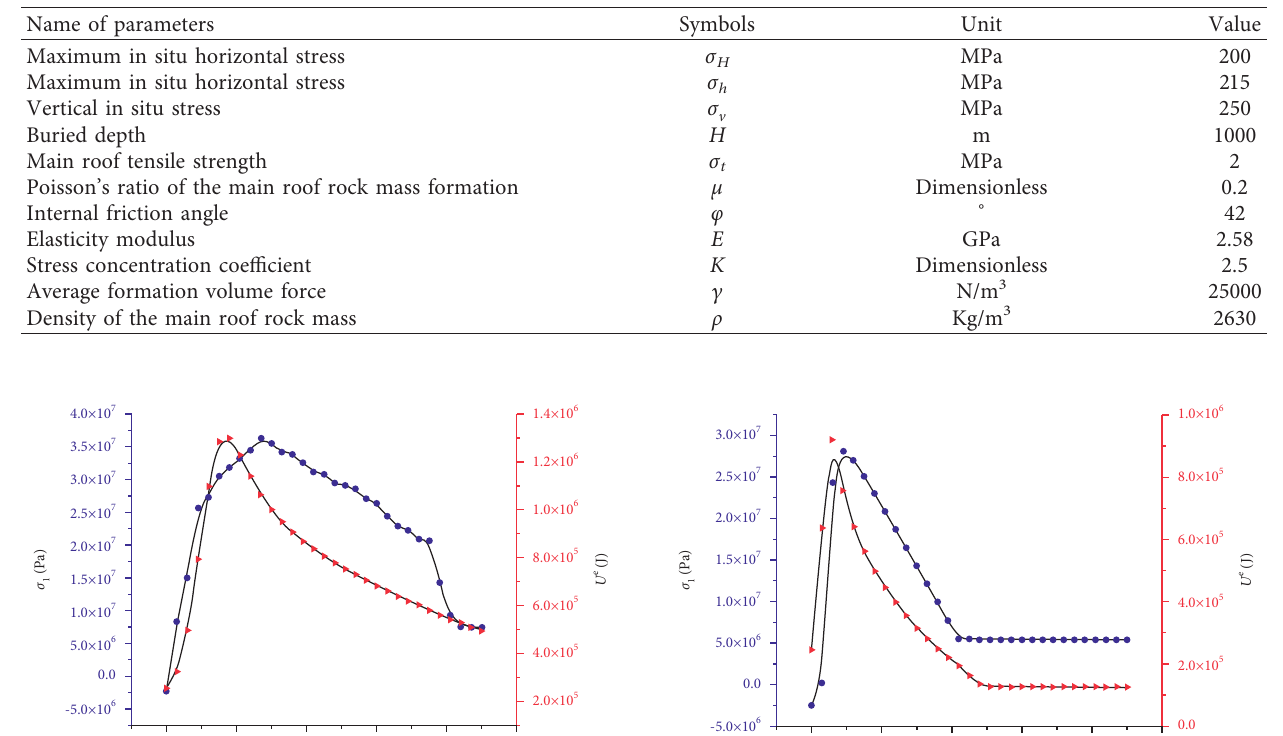
Table 1: Main parameters of geological conditions and technical conditions.